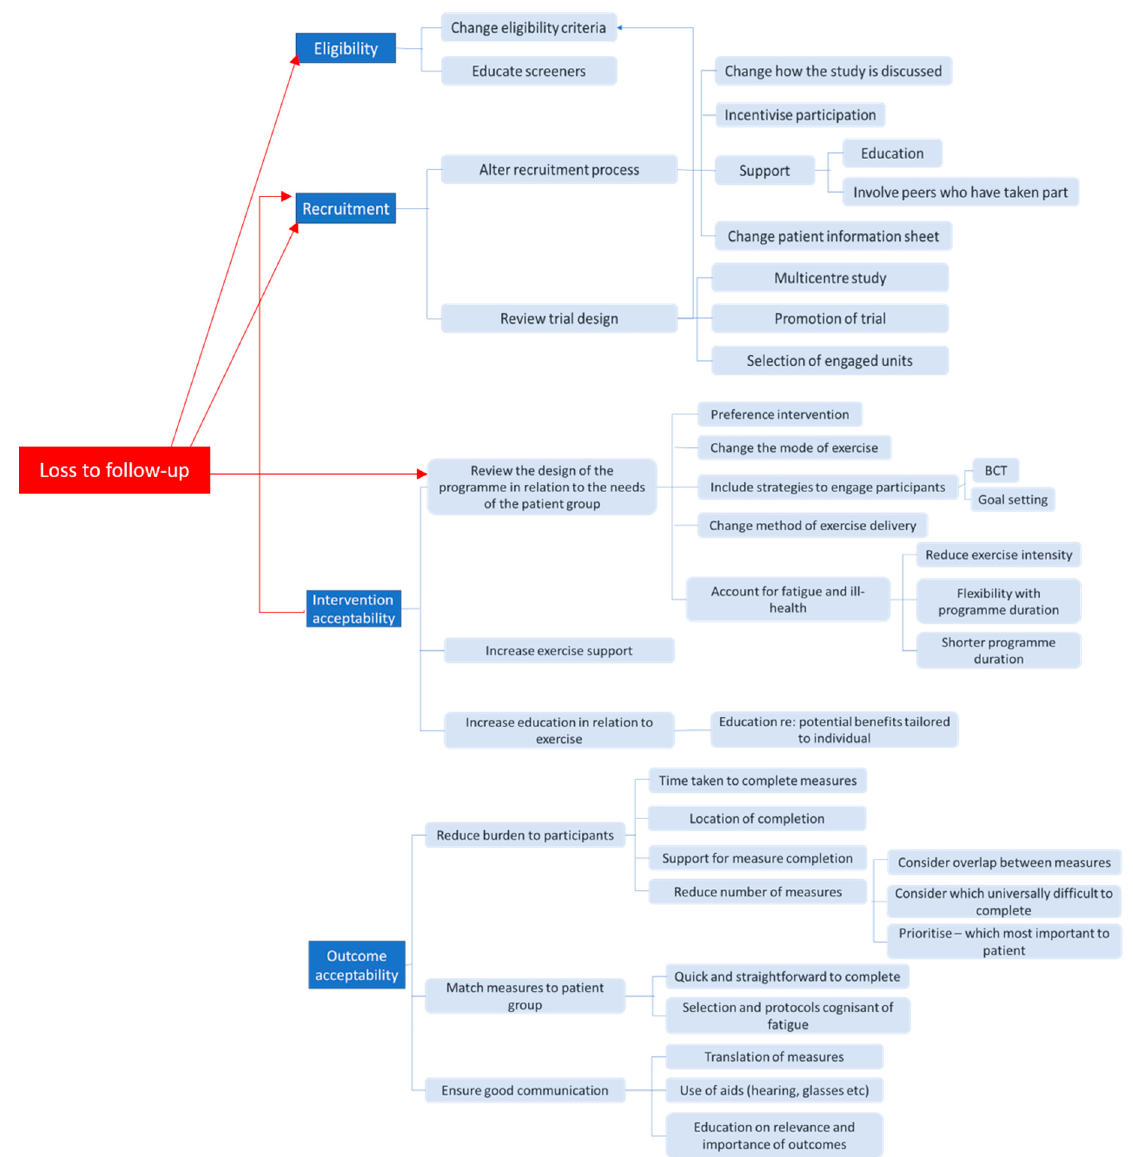
Figure 5. Suggestions for amendments to the trial and intervention should thresholds for ‘change’ criteria be met; BCT: Behaviour change techniques.